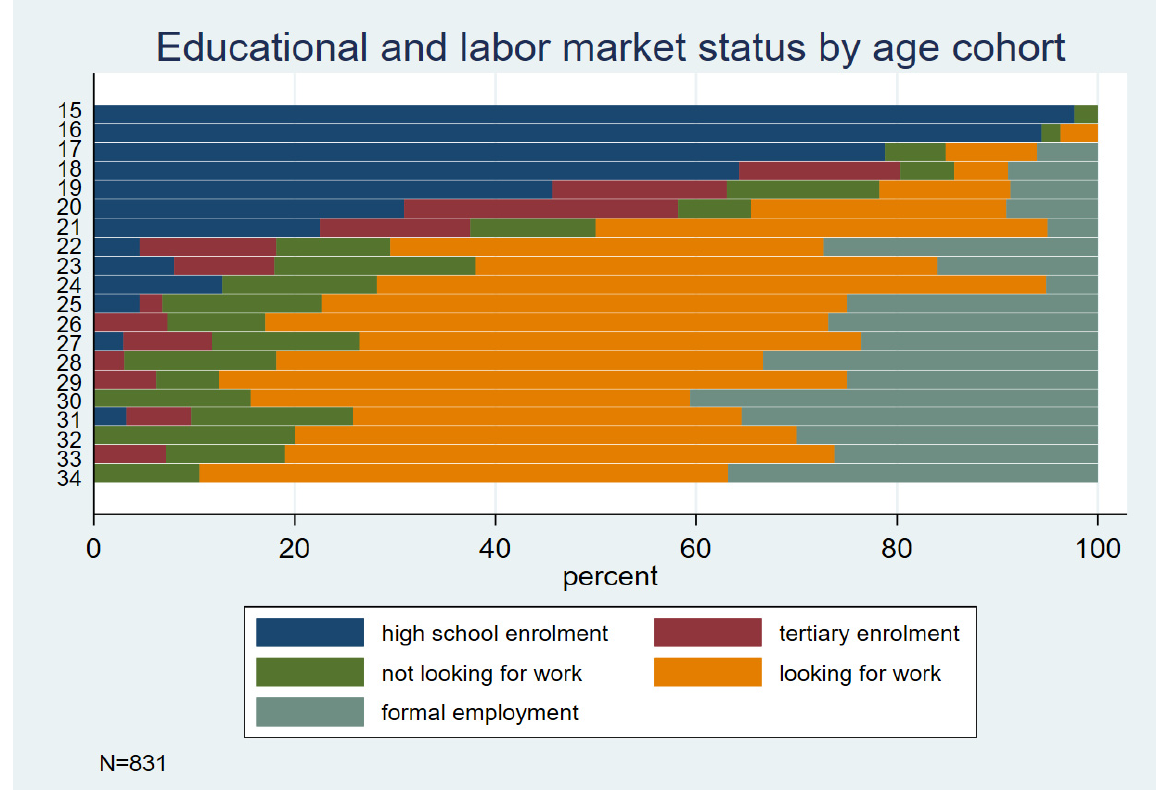
Figure 1. Educational and labor market status by age